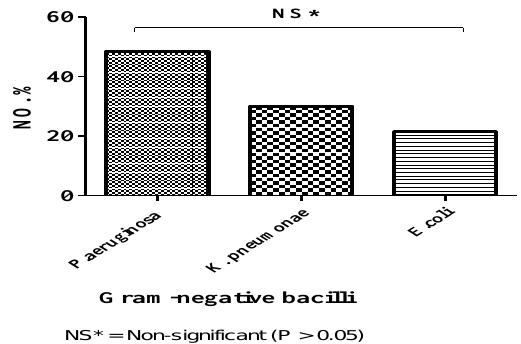
Figure 2. Types of Gram-negative bacilli isolated from burn wound infections.